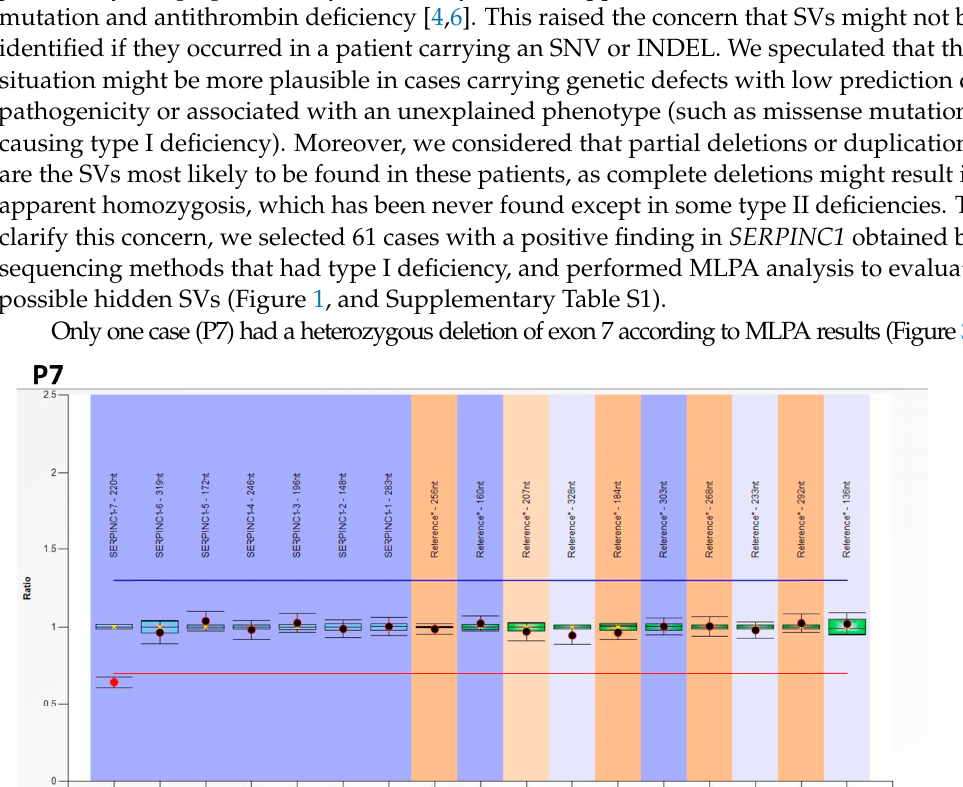
Figure 2. Representation of two SERPINC1 deletions affecting exon 2 not precisely identified by MLPA in two patients with antithrombin deficiency. The length of the deletion, the position of the MLPA probes and the results generated by this technique are indicated.